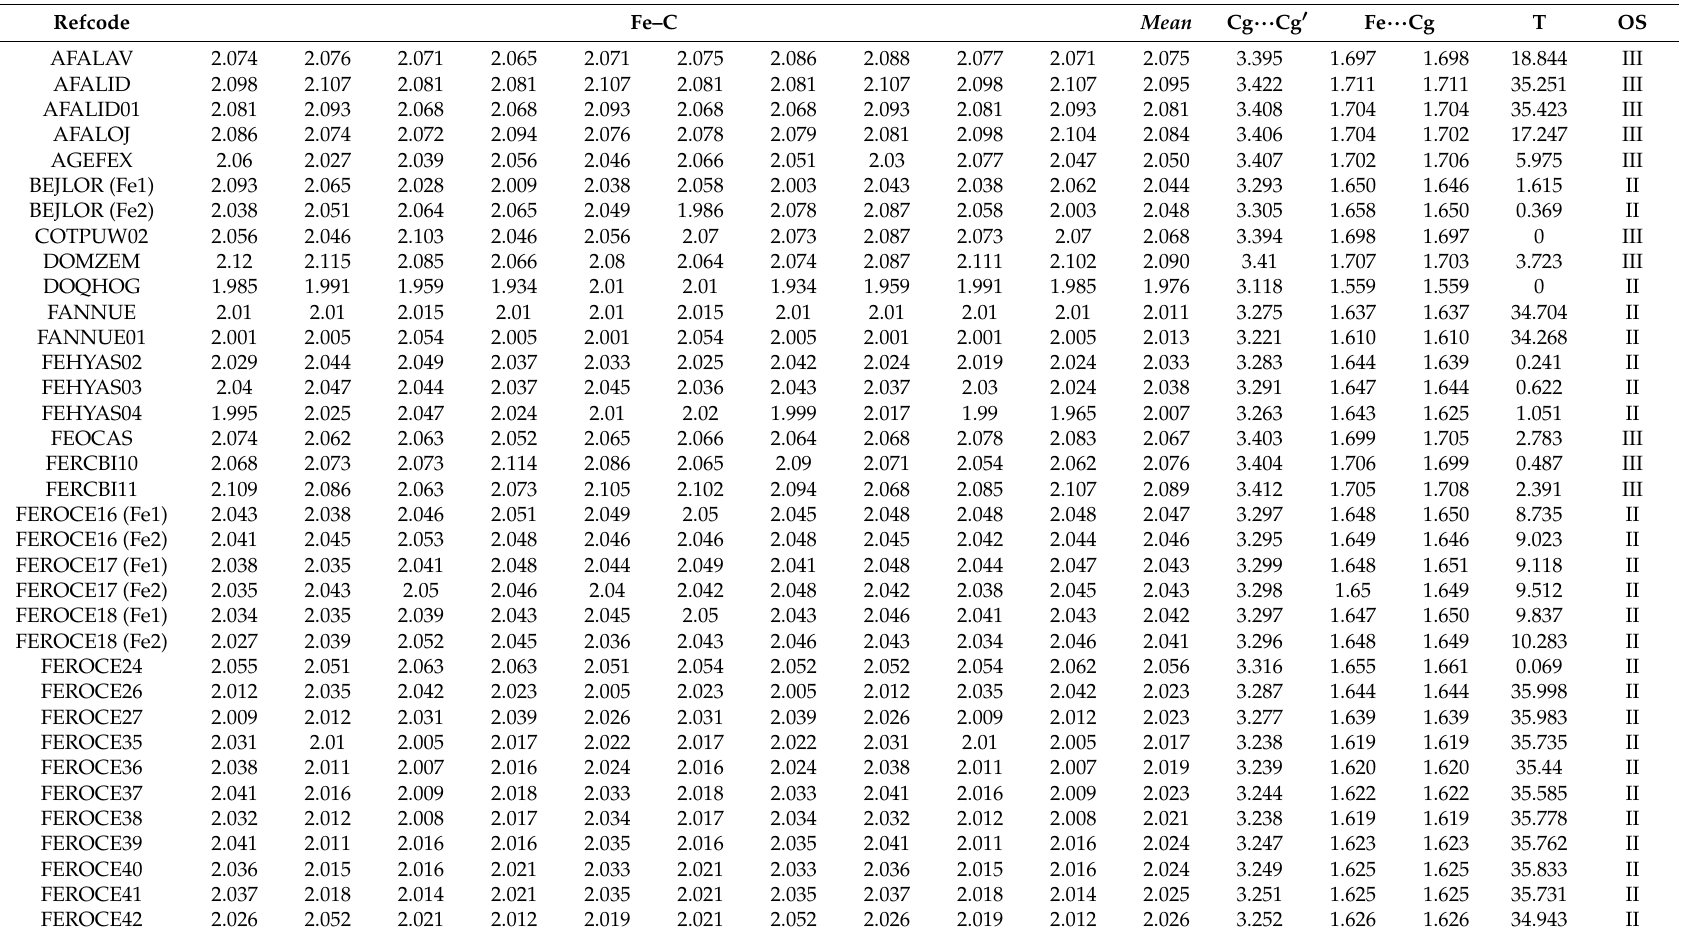
Table A2. Selected distances (Å), torsion angles (T, ◦ ) and oxidation states of Fe centres (OS) for all the structures containing pristine ferrocenyl units included in the CSD